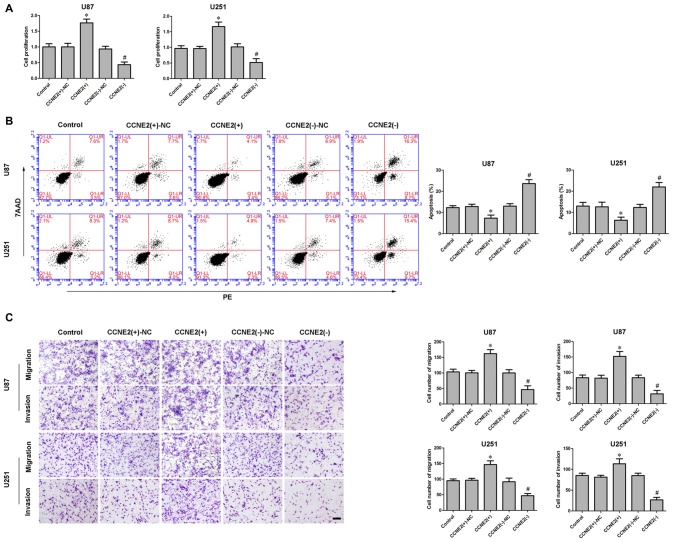
Effect of CCNE2 on proliferation, migration, invasion and apoptosis of human glioma cells. (A) CCK-8 assay was used to determine the proliferation effect of CCNE2 on human glioma cells. *P < 0.05 vs. CCNE2 (+)-NC group; #P < 0.05 vs. CCNE2 (−)-NC group. (B) Flow cytometry analysis of human glioma cells with the expression of CCNE2 changed. *P < 0.05 vs. CCNE2 (+)-NC group; #P < 0.05 vs. CCNE2 (−)-NC group. (C) Quantification of migration and invasion cells with the expression of CCNE2 changed. Representative images and accompanying statistical plots were presented. *P < 0.05 vs. CCNE2 (+)-NC group; #P < 0.05 vs. CCNE2 (−)-NC group. Scale bars represent 20 μm.